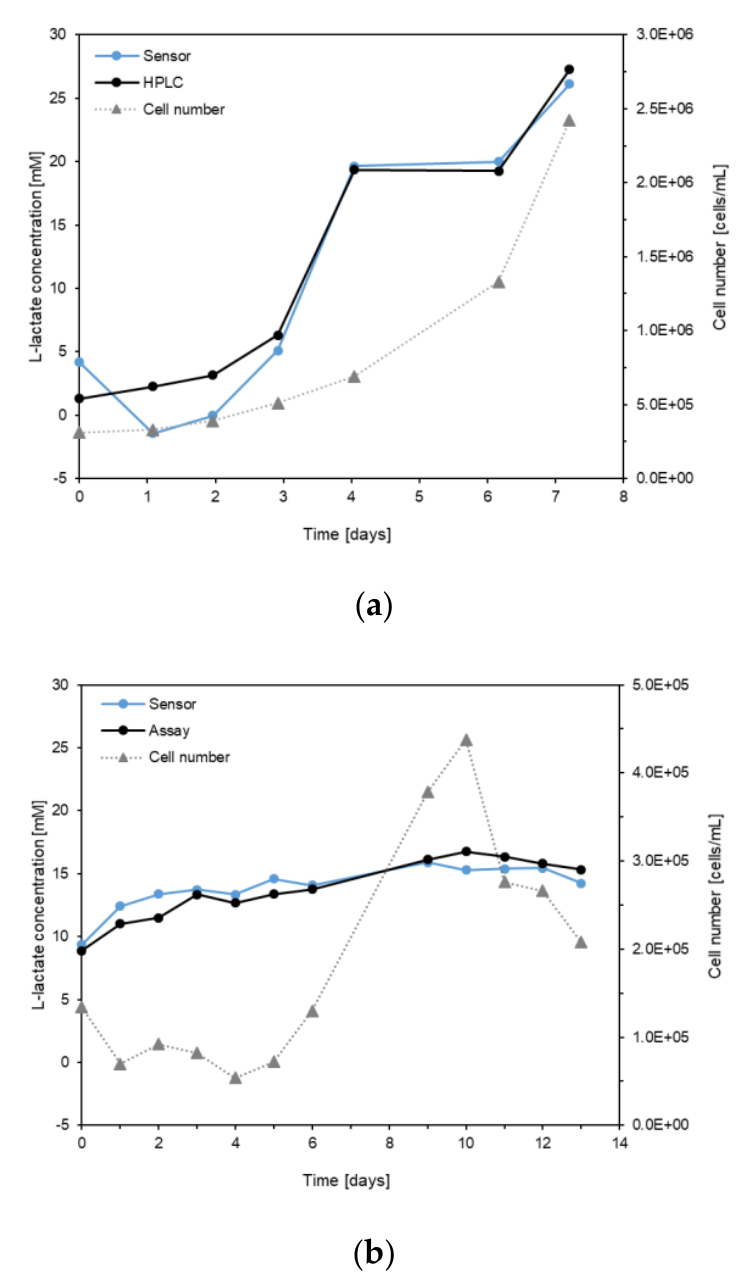
Figure 7. Mammalian cell culture measurements at line using the single-use biosensor. ( a ) Seven-day batch cultivation showing lactate measurements with the single-use biosensor in comparison with o ff -line HPLC data; ( b ) Thirteen-day fed-batch cultivation showing lactate measurements with the single-use biosensor in comparison with o ff -line spectroscopic lactate assay data. The growth profiles of CHO cell cultures are shown in ( a ) and ( b ) from viability assays.